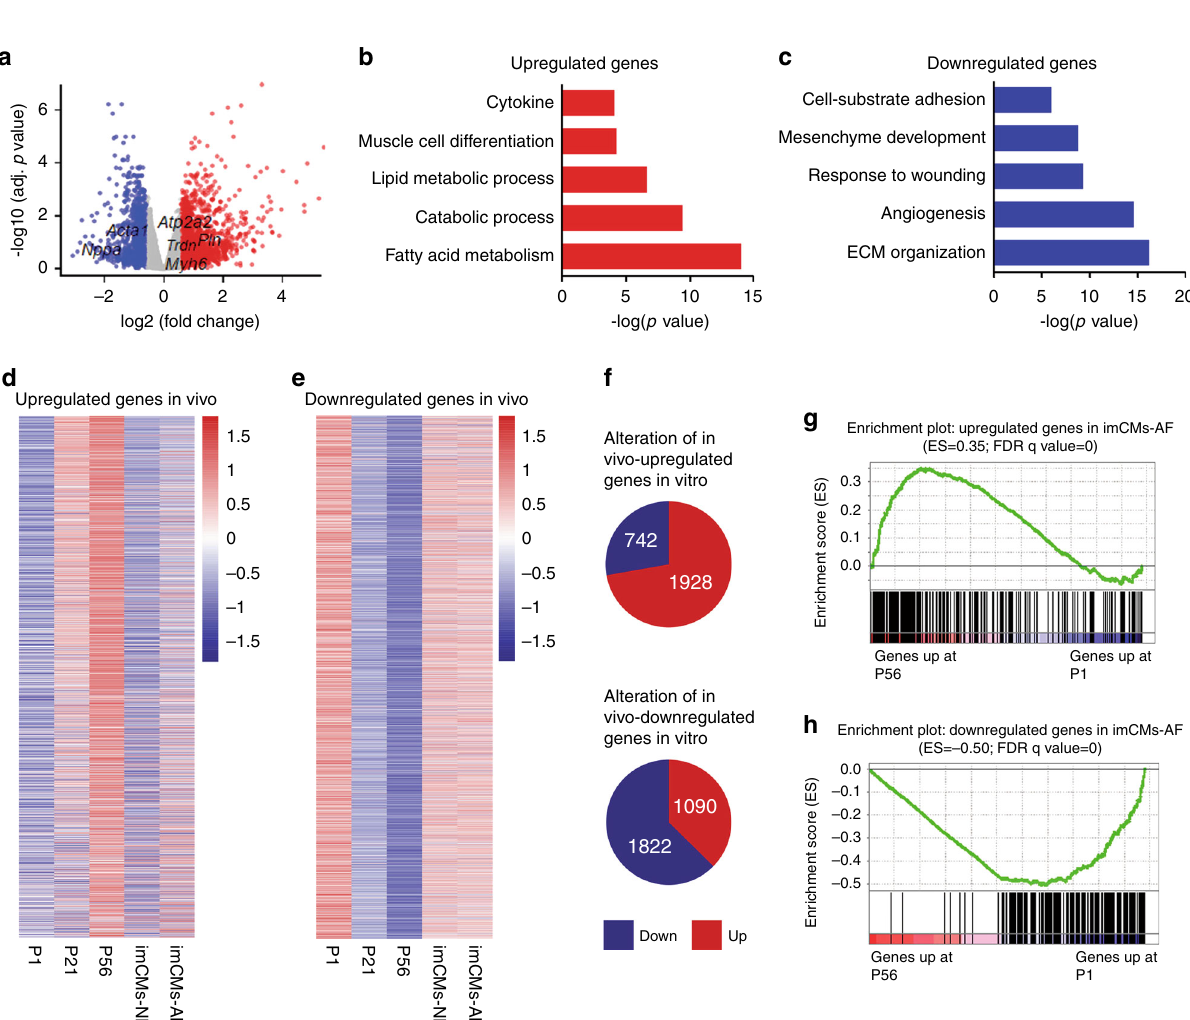
Fig. 4 Adult cardiac fi broblasts promote maturation of neonatal CMs. a Schematic of in vitro co-culture of cardiomyocytes and cardiac fi broblasts. Freshly isolated immature CMs (imCMs) from P1 mouse hearts were immediately co-cultured with fi broblast monolayers from either neonatal (P1, NF) heart or adult (P56, AF) hearts, respectively. b Immuno fl uorescent staining against ACTN2 and pH3 in imCMs 3.5 days after co-culture. White arrows indicate cells with co-localization. Scale bars = 10 or 25 μ m. c Quanti fi cation of ACTN2 + AURKB + , ACTN2 + MKI67 + , and ACTN2 + pH3 + cells 3.5 days after co-culture. d , e Immunostaining against ACTN2 and Phalloidin in co-cultures. Representative images to show typical class I – II ( d ) and class III – IV ( e ) CM morphology, respectively. f Quanti fi cation of d , e . g Representative action potential tracings of imCMs in co-culture. h – m Quanti fi cation of beating frequency ( h ), action potential duration to 50 and 90% repolarization (APD50, i ; APD90, j ), maximum diastolic potential (MDP, k ), action potential amplitude (APA, l ), and maximum rate of rise (d V /d t max ) of action potential ( m ) of co-cultured imCMs. n = 13 cells. n Representative I Na tracings of imCMs in co-culture with voltage control. o Quanti fi cation of n . n = 12 cells in imCM-NF = 13 cells in imCM-AF. p Representative I to tracings of imCMs in co-culture. q Quanti fi cation of I to ( p ) n = 11 cells. r Representative I k tracings of imCMs in co-culture. s Quanti fi cation of I K in r . n = 10 cells in imCM-NF = 15 cells in imCM-AF ( r ). t Representative images to show T-tubule structure in imCMs in co-culture. T-tubule was labeled by di-8-ANEPPS. u Quanti- fi cation of T-tubule density in t . Image J was applied in quanti fi cation. v Immuno fl uorescent staining of ACTN2 and GJA1 in imCMs 3.5 days into co-culture. White arrows indicate co-localized cells. Scale bar = 10 or 25 μ m. w Quanti fi cation of v . All data in this fi gure are plotted as mean ± SEM from three biologically independent experiments, * p < 0.05, ** p < 0.01, *** p < 0.001, n.s. not signi fi cant, two-sided Student ’ s t -test. Source data are provided as a Source Data fi le.